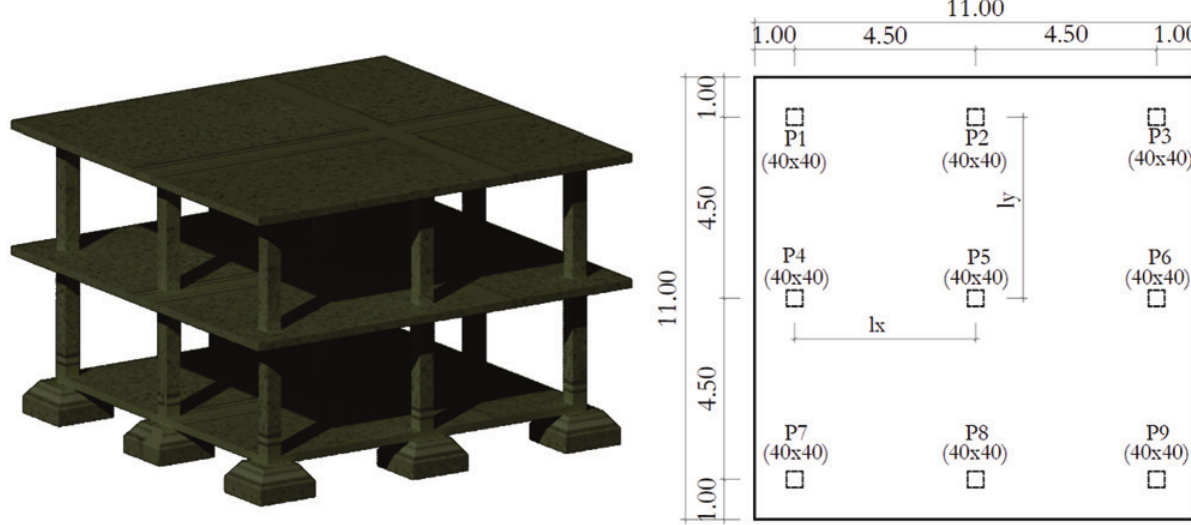
Figura 1 Perspectiva e planta baixa da laje lisa sem armadura de cisalhamento